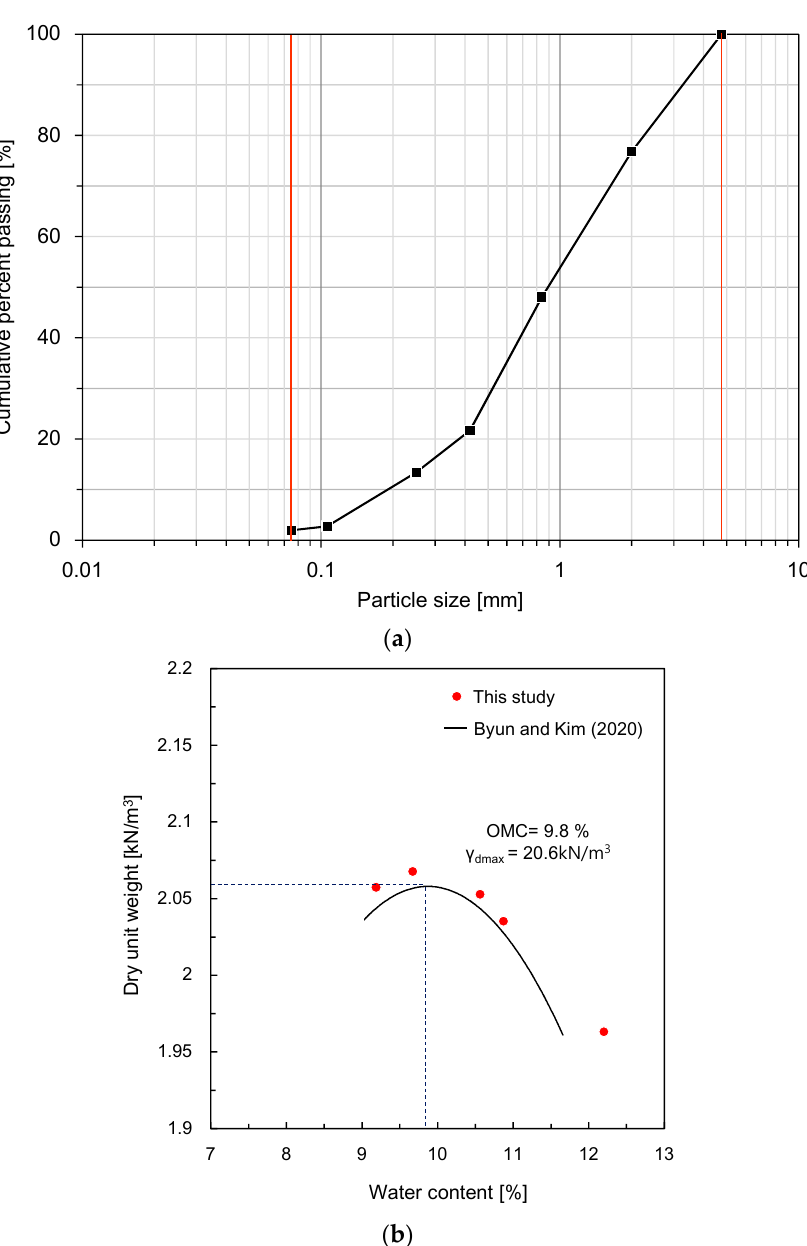
Sensors 2021 , 21 , 1226 Figure 2. Properties of the compacted soils: ( a ) particle size distribution; ( b ) compaction curve. Table 1. Index properties of the soil used in this study.